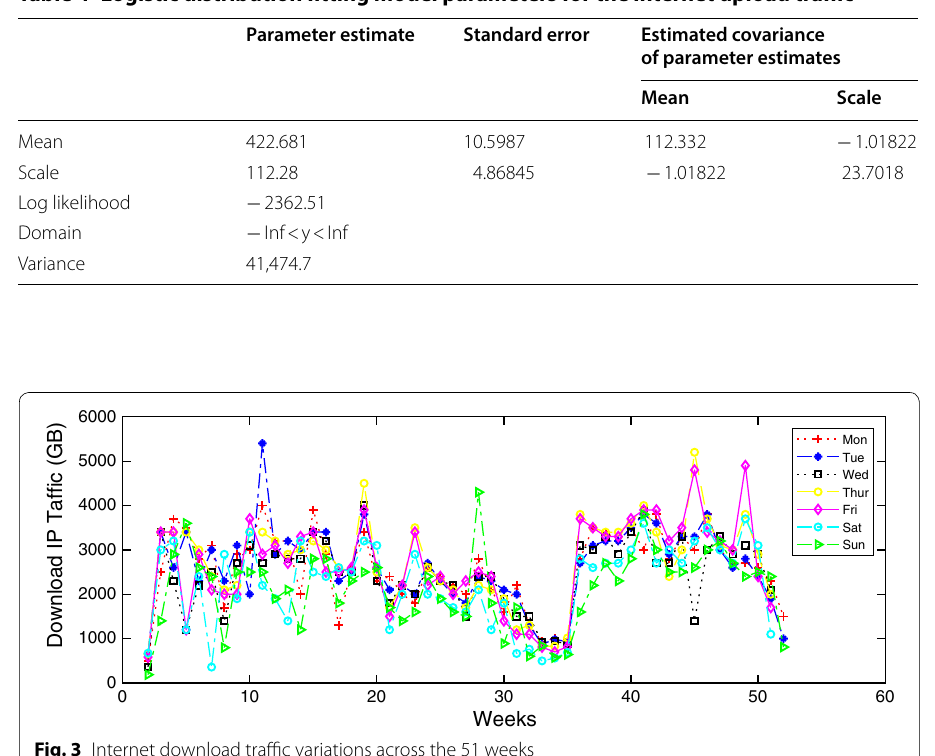
Fig. 3 Internet download traffic variations across the 51 weeks